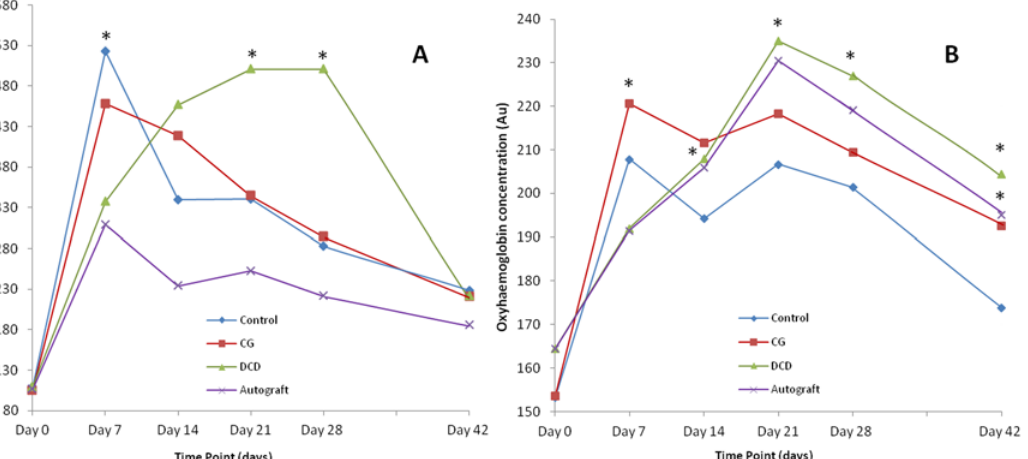
Figure 3. Haemoglobin flux and oxyhaemoglobin concentration. Change in haemoglobin flux (A) and oxyhaemoglobin concentration (B) after wounding in all treatment groups derived from full-field laser perfusion imaging (FLPI) and spectrophotometric intracutaneous analysis (SIAscopy) respectively. Non- invasive imaging confirms significantly up-regulated haemoglobin flux and oxyhaemoglobin concentration after treatment with DCD compared to controls. * p < 0.05 n = 10/treatment